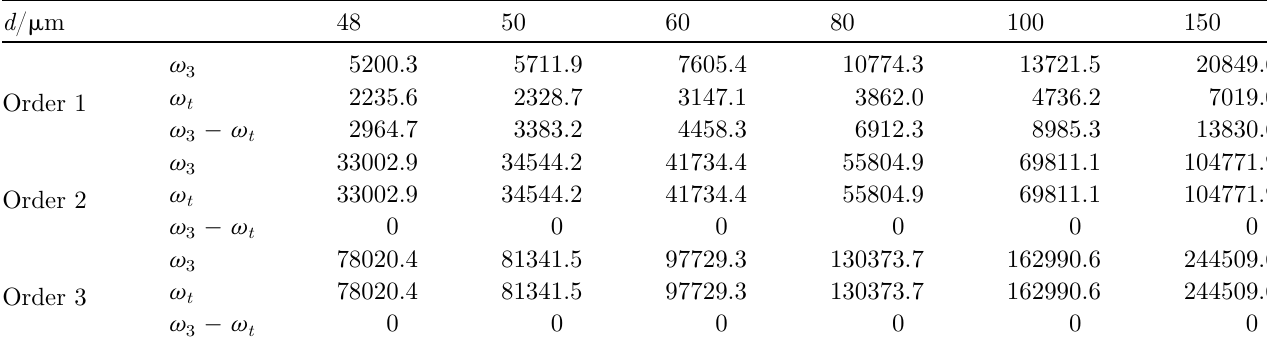
Table 7. Changes of natural frequency with d with and without friction force (rad/s).